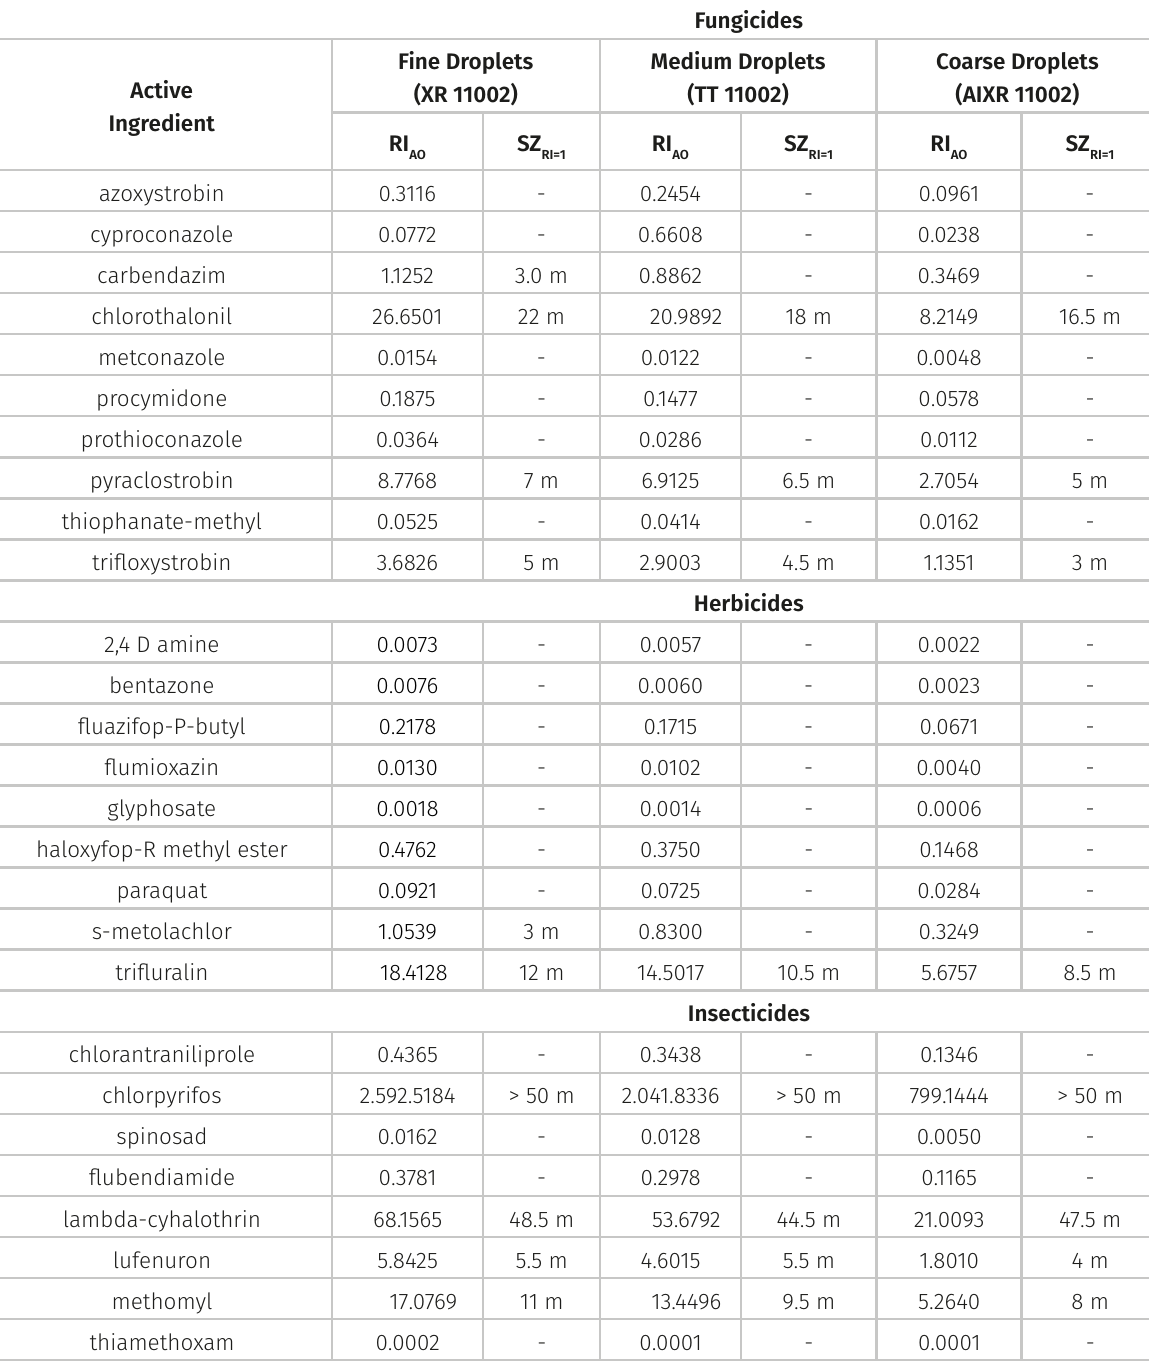
Table VII. Risk indices and buffer zones for aquatic organisms due to drift 2.5 m from the target area resulting from the application of recommended phytosanitary products to control diseases, weeds and pests in